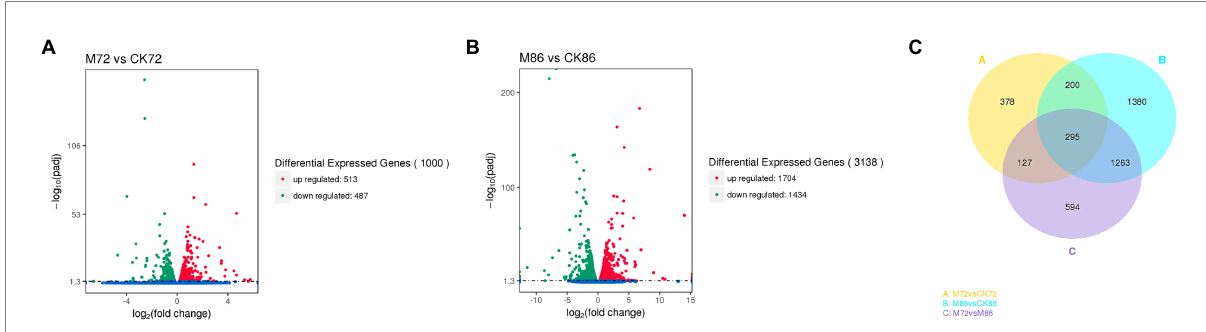
FIGURE 3 Volcano map and Venn diagram of differentially expressed genes (DEGs). Volcano map of DEGs of (A) 72 h samples and (B) 86 h samples. The transverse coordinates represent multiple changes in genes expression in different samples, while the longitudinal coordinates represent the significant variations in gene expression; the DEGs are represented as red dots (upregulation) and green dots (downregulation), while blue dots (unchanged). (C) Venn diagram showing DEGs among three experimental groups (A–C)